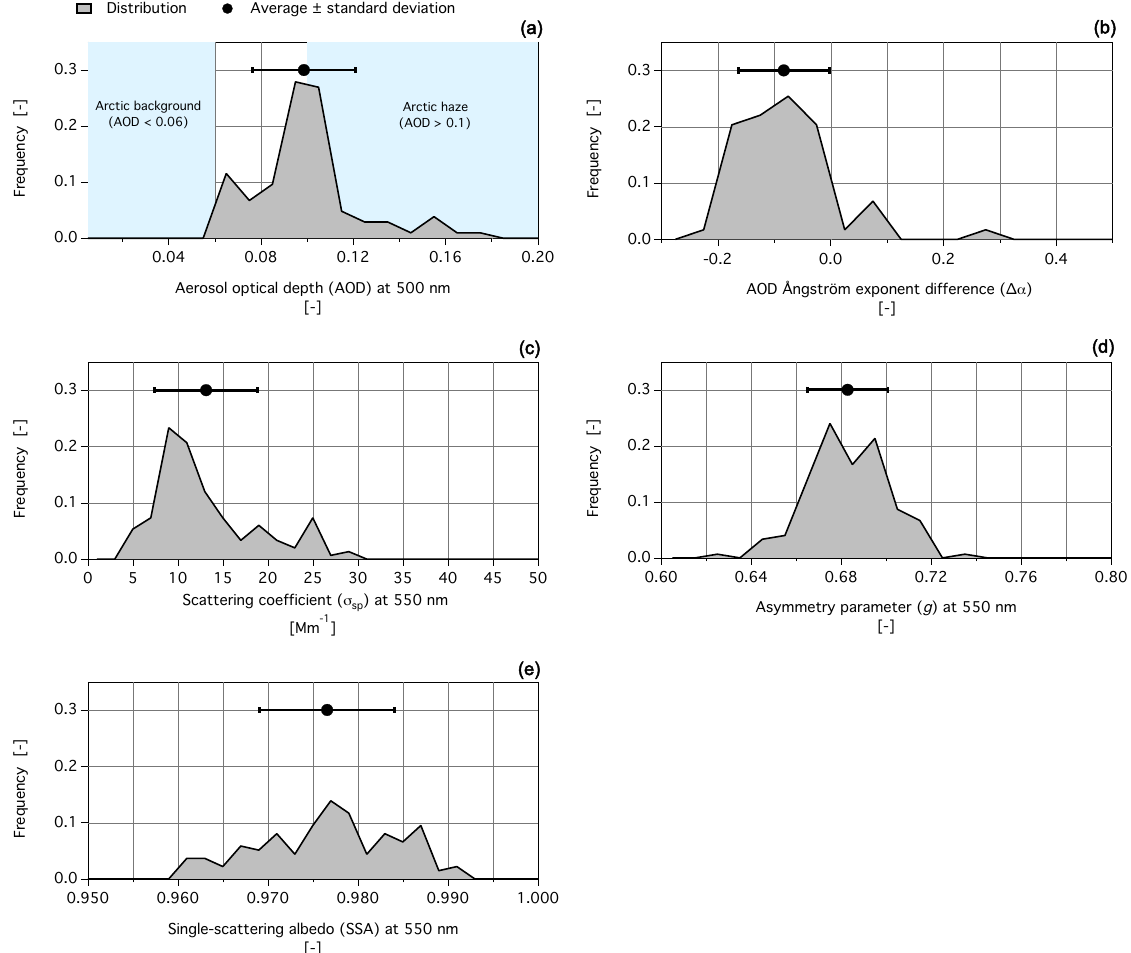
Figure 2. Histograms of main aerosol properties calculated from 2h averages. (a) Aerosol optical depth (AOD) at 500nm, where AOD values > 0 . 1 and < 0 . 06 represent haze and background conditions, respectively (Yamanouchi et al., 2005); (b) difference of Ångström exponent ( (cid:49)α ) of AOD between 675–862 and 412–675 nm; (c) asymmetry parameter ( g ) of the dry aerosol at 550nm; (e) single-scattering albedo (SSA) of the dry aerosol at